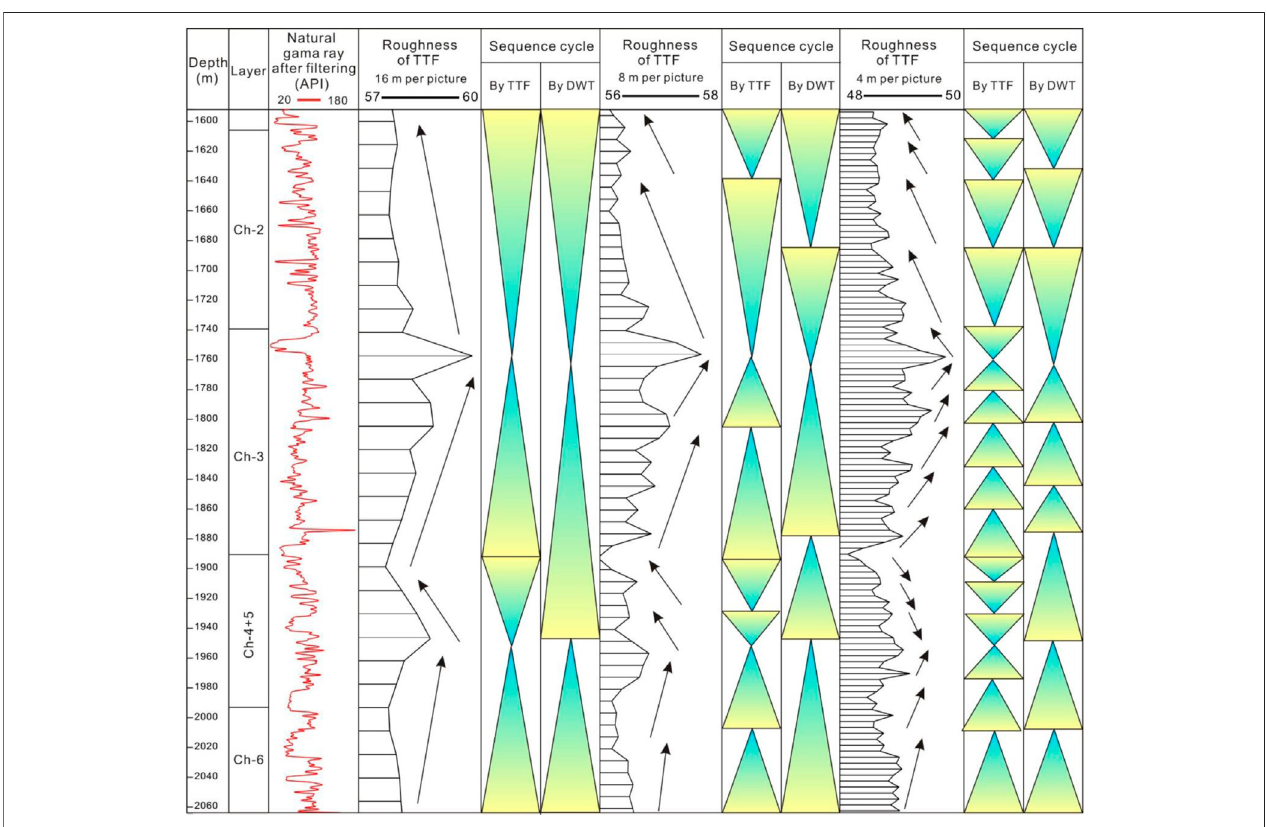
FIGURE 16 | Comparison between TTF and CWT sedimentation cycle recognition